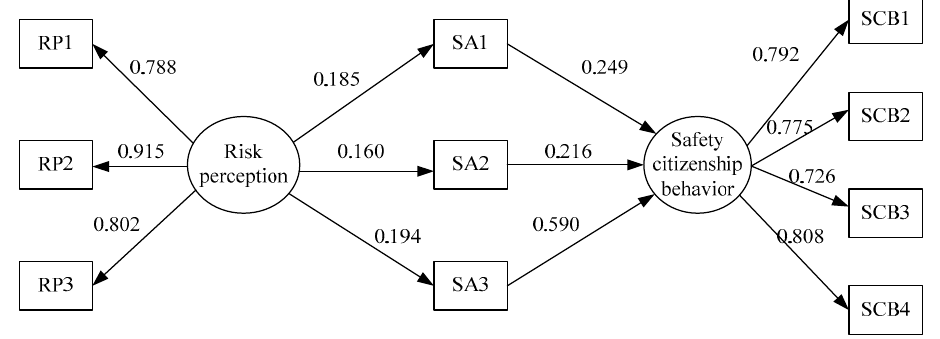
Figure 4. The standardized results of model M3.